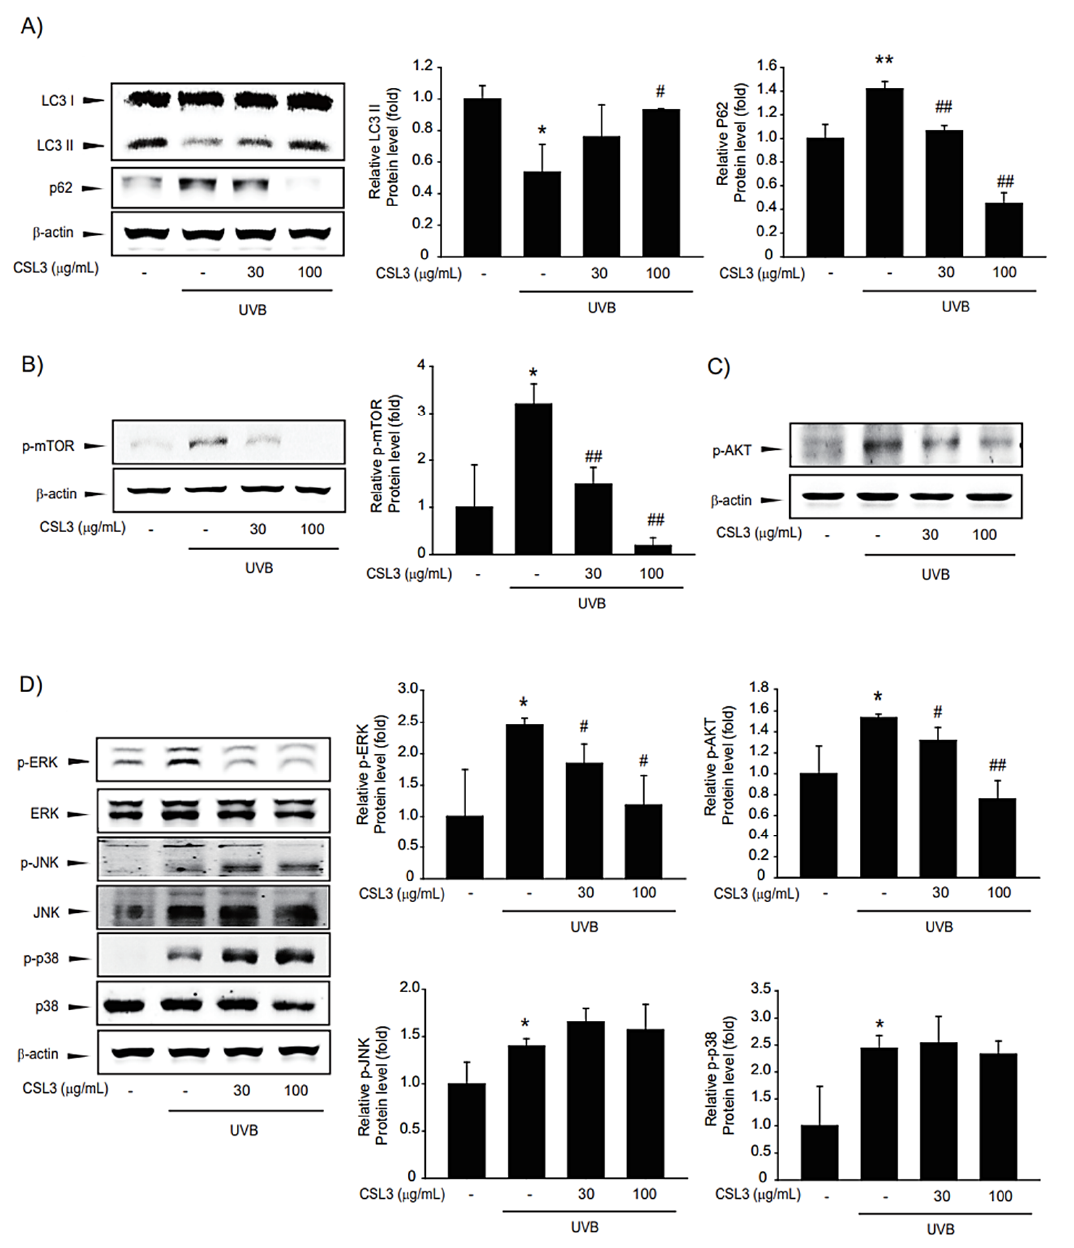
Figure 6. Effects of CSL3 on autophagy in UVB-irradiated HaCaT cells. ( A ) Effect of CSL3